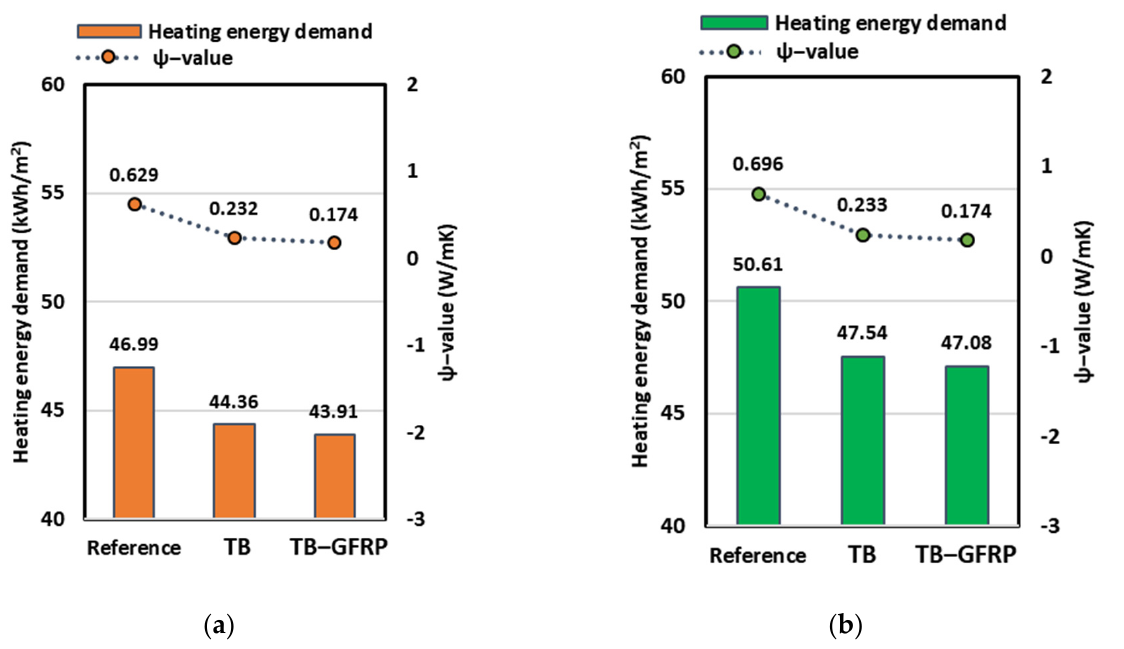
Figure 7. Heating energy demand under air heating condition: ( a ) External insulation; ( b ) Internal insulation.